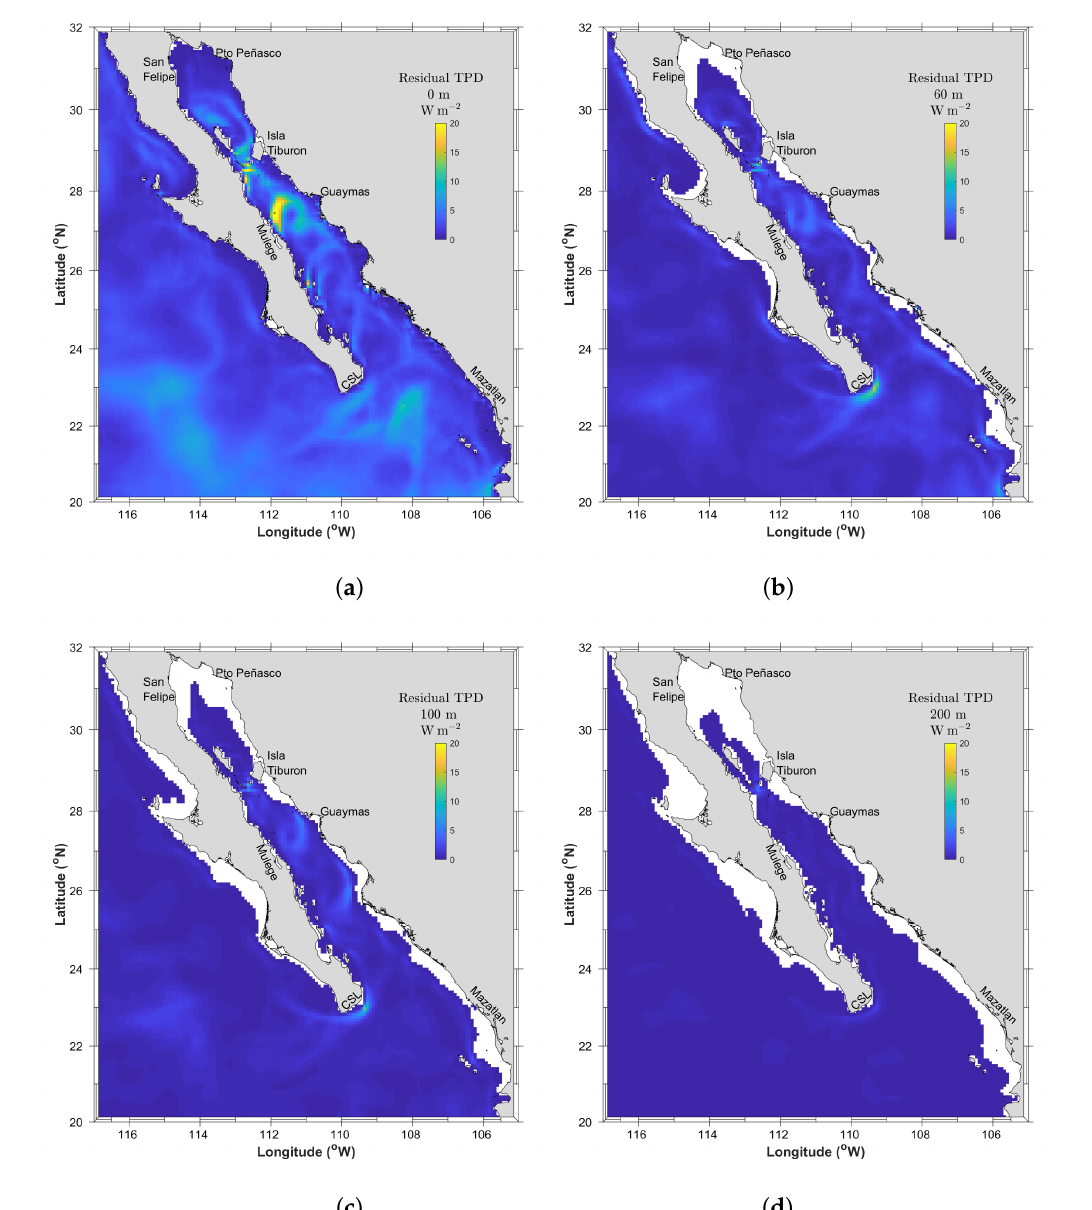
Figure 8. Residual TPD at ( a ) 0 m, ( b ) 60 m, ( c ) 100 m, and ( d ) 200 m below Mean Sea